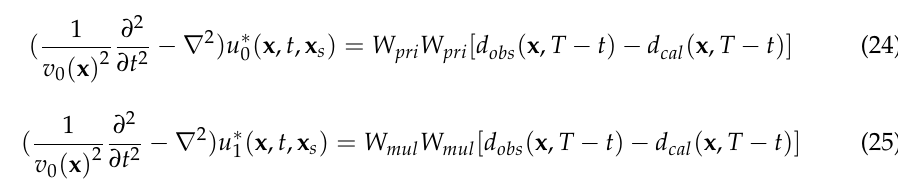
is the upward of the primary and